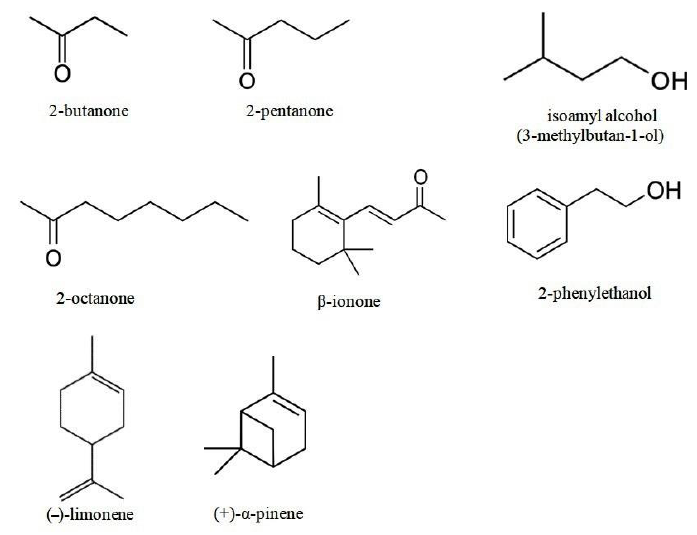
Figure 1. Volatile organic compounds used in this